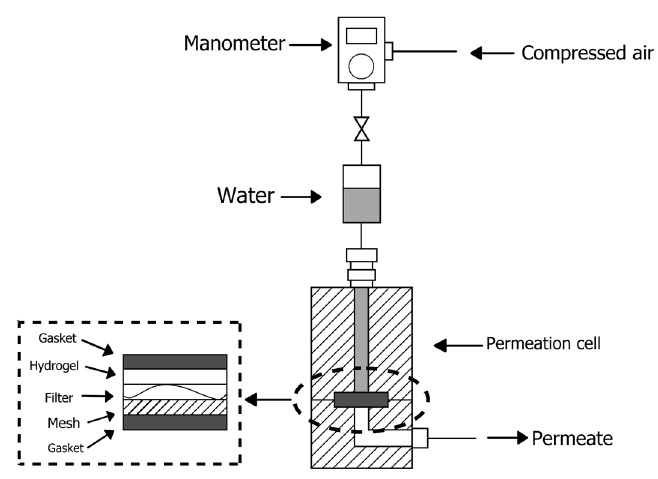
Figure 4. Schematic diagram of apparatus for the determination of hydrodynamic permeability.